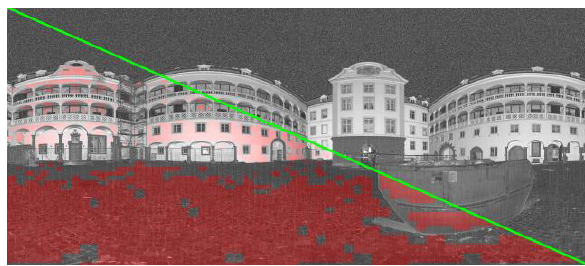
Figure 4. Generated intensity image (upper right) and detected planes tinted in red (lower left) (Wujanz et al., 2018)